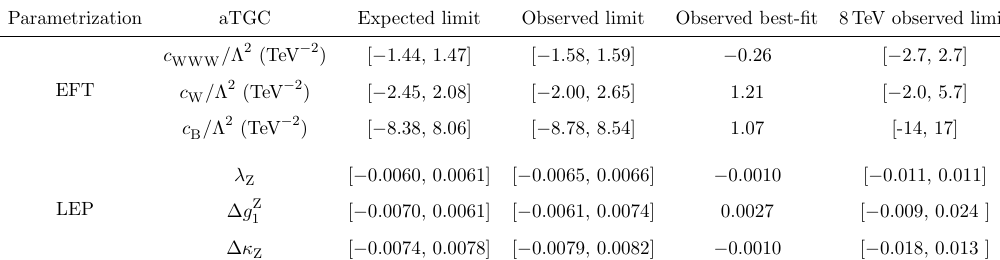
Table 4 . Expected and observed limits at 95% CL on single anomalous couplings, along with observed best-(cid:12)t values, for both the EFT and LEP parametrizations. For each coupling, all other couplings are explicitly set to zero. Observed limits from collision data taken at a centre-of-mass energy of 8 TeV [26] are also quoted for comparison.